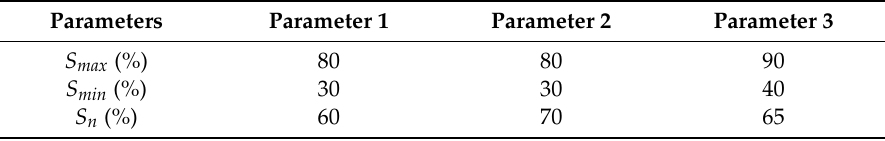
Table 6. Simple parameters for simulation duration